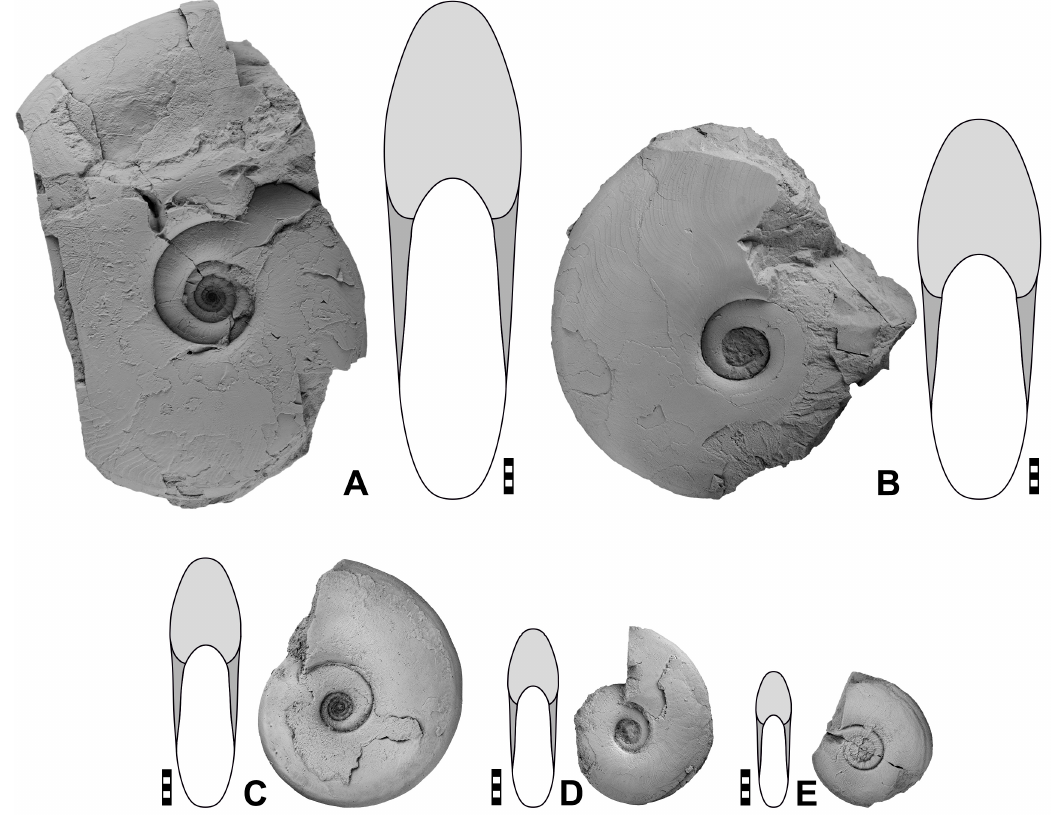
Fig. 17. Koenenites lamellosus (Sandberger & Sandberger, 1851). A . Specimen MB.C.22184 (Koch Coll.) from Oberscheld (Anna Mine). B . Specimen MB.C.22183 (Dannenberg Coll.)